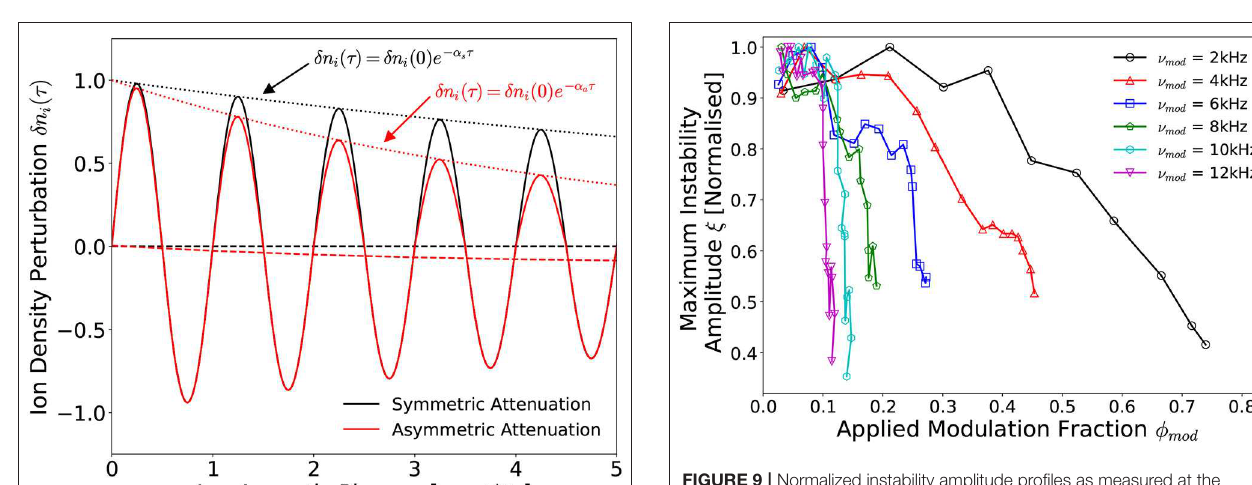
FIGURE 9 | Normalized instability amplitude profiles as measured at the beam-conic interface downstream of the DL (R, Z = –6 cm, 2 cm) with respect to voltage amplitude modulation frequency 2 kHz ≤ ν mod ≤ 12 kHz and modulation fraction 0.0 ≤ φ mod ≤ 0.74. Solid lines added to guide the eye. Operating conditions: helicon antenna supplied P rf = 300 W at ν rf = 13.56 MHz employing 0.42 mTorr argon with I 1,2 = 6 A solenoid